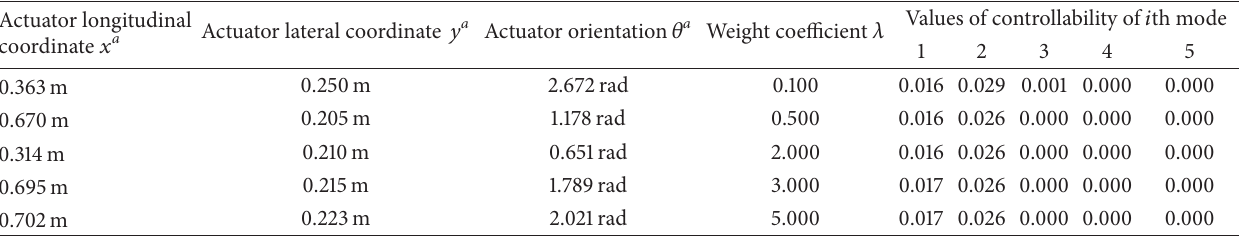
Table 7: The effect of values of the weight coefficients on the controllability for a single actuator for the case that the first two modes are controlled.